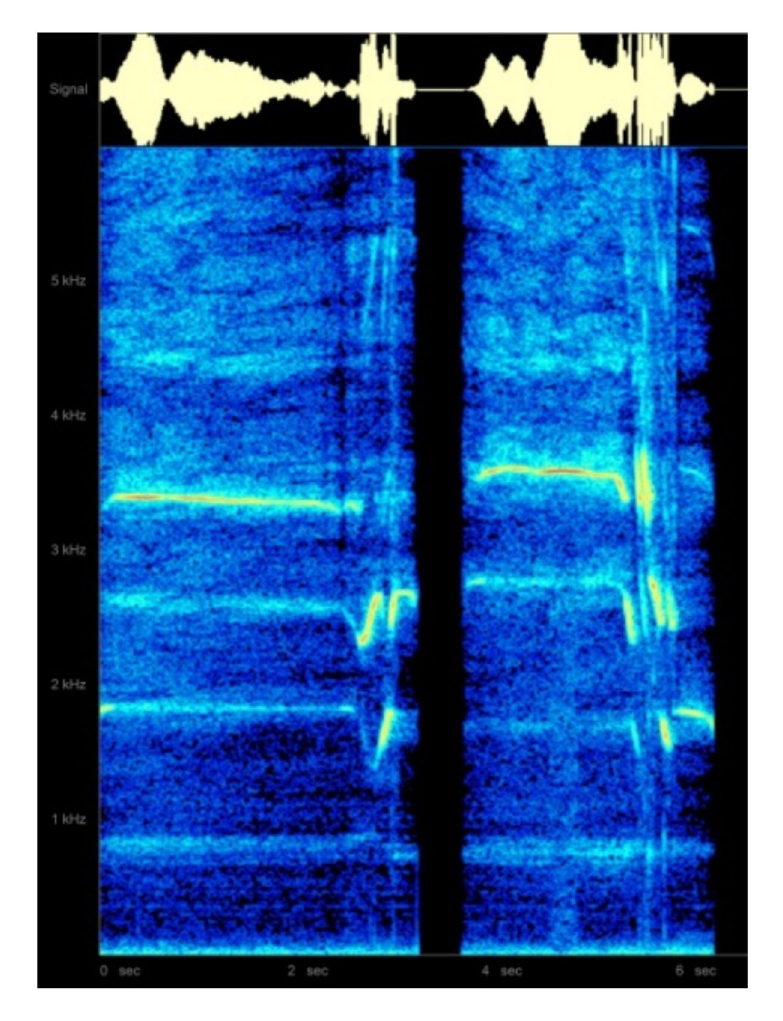
Figure 32. Spectrogram of piston whistle, Teotihuacan (MNA, Inv. 10-223558), overblown, two movements; left (Position 1): upwards, ascending alternating glissando effect; right (Position 2): downwards, descending glissando effect (Sample